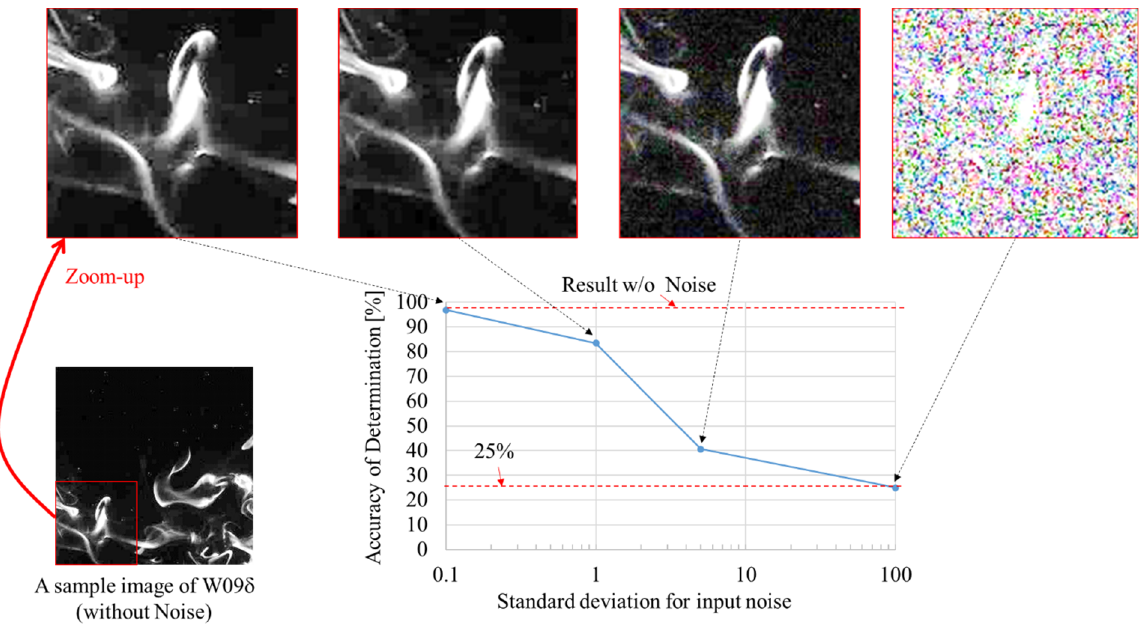
Figure 10. Accuracy of determination with noisy input image for four classes of W0.9 δ by Gaussian noise with a zero mean for the luminance of image.